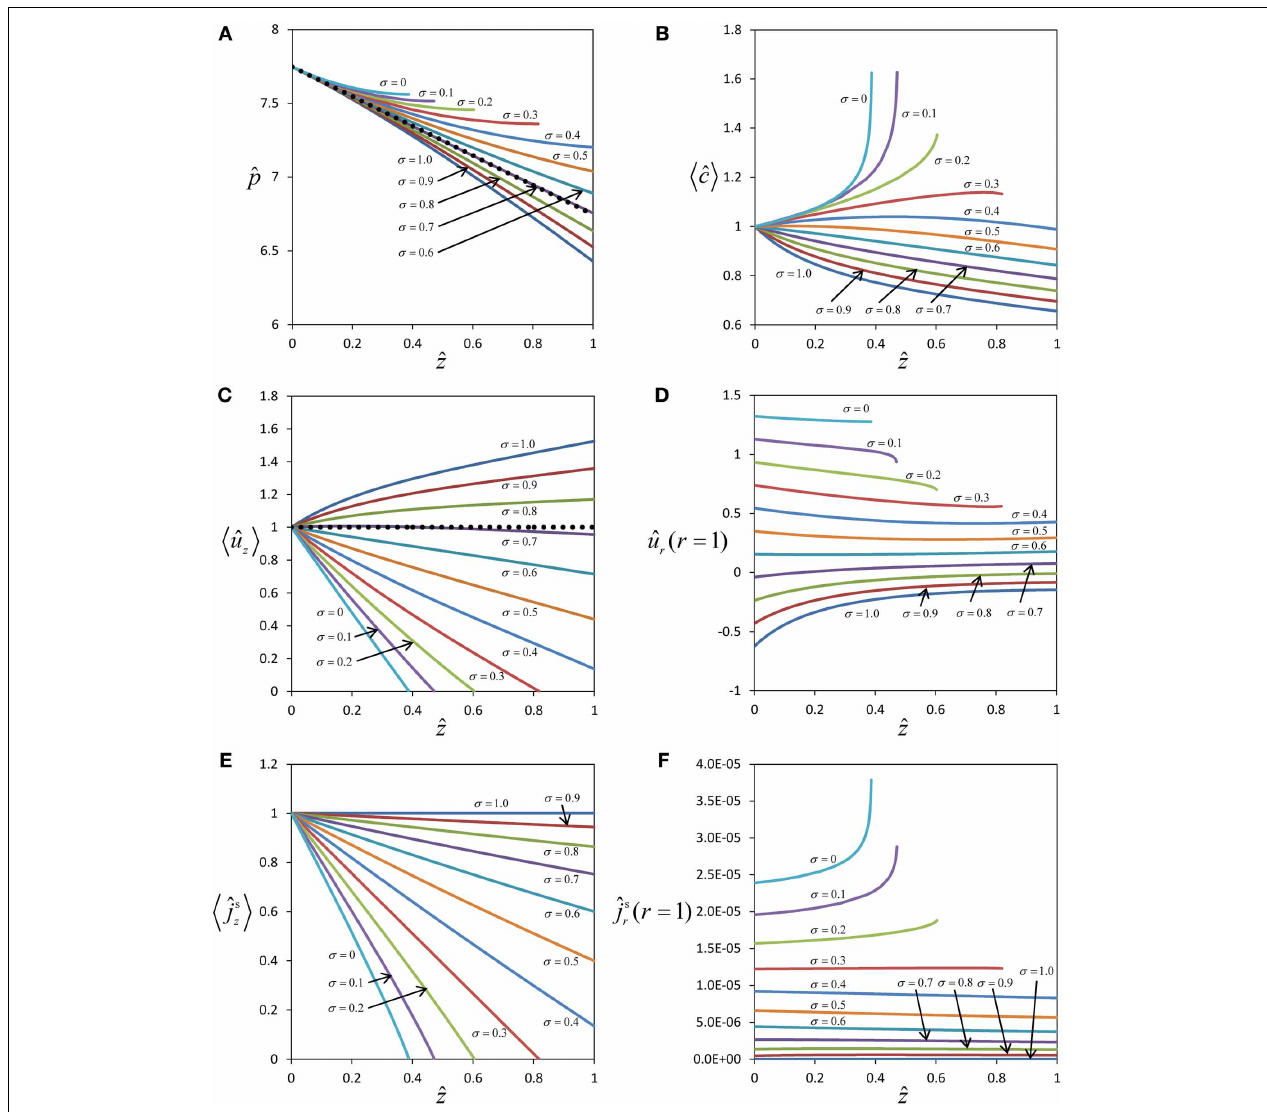
FIGURE 2 | Effect of solute permeability on the flow within a sieve tube limited by a permeable membrane. Pressure (A) , average concentration (B) , average axial velocity (C) , radial velocity at sieve tube membrane (D) , axial (E)